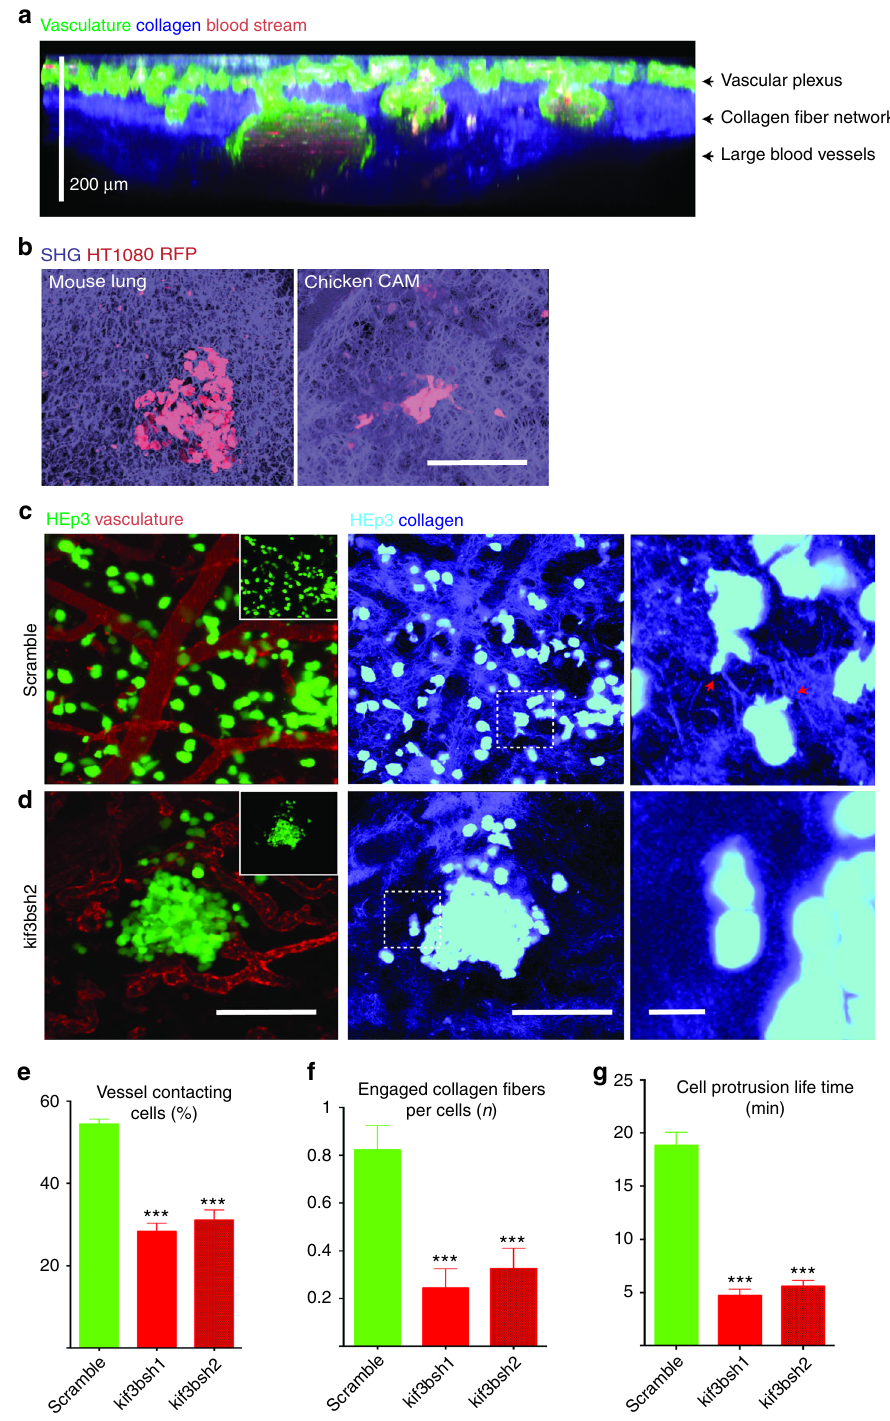
Fig. 3 Kif3b is required for metastatic HEp3 cancer cell vasculotropism and invasion into the extracellular matrix in vivo. Multicolor two-photon intravital imaging was utilized to visualize the chicken CAM structure and cancer cell behavior within metastatic cancer cell colonies. a Chicken CAM structure, 15dpf. FITC-lectin (green) was used for visualization of the vasculature, SHG (blue) for imaging of collagen fi ber network and auto- fl uorescence (red) for imaging of the blood. b Representative images showing similarity in the collagen matrix structure between the mouse lung (left panel) and chicken CAM (right panel). Metastatic colonies that were formed by control ( c , scramble shRNA) and Kif3b shRNA2-transduced HEp3 cells ( d ). Right panels in ( c ) and ( d ) show higher magni fi cation of areas in middle (SHG) panels. Red arrows point to cancer cell protrusions that are in contact with collagen fi bers. Note that control cells robustly interact with the vasculature and invade into the collagen matrix while shRNA2 Kif3b cells fail to do so. Insets show only tumor cell (GFP) channel. e Quanti fi cation of the fraction of cells in contact with blood vessels for HEp3 control and Kif3b knockdown cells. f Average number of cancer cell engaged collagen fi bers for HEp3 control and shRNA2 Kif3b cells. g Average cell protrusion lifetime for control and shRNA2 Kif3b cells (see also Supplementary Movie 3). Scale bars = 200 μ m ( a , b ); 200 μ m ( c , d , left and middle panels) or 20 μ m ( c , d , right